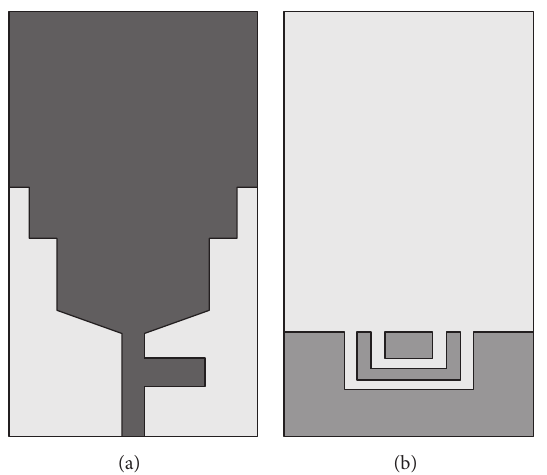
Figure 24: A microstrip monopole antenna with a defected ground structure [37]. The presence of the U-shaped DGS structure and of the stub is evident in the figure. Dark gray upper metal face, medium gray bottom metal face, and light gray dielectric substrate. Top view (a) and bottom view (b).